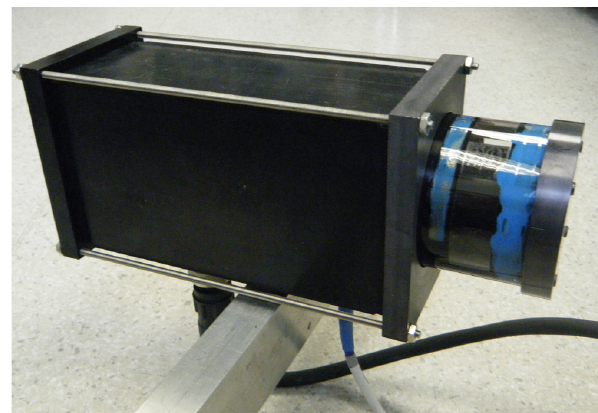
Fig. 2. A photograph of the scan head. The view window is the clear quartz region between two defroster heaters that appear blue due to the blue thermally conductive epoxy glue.